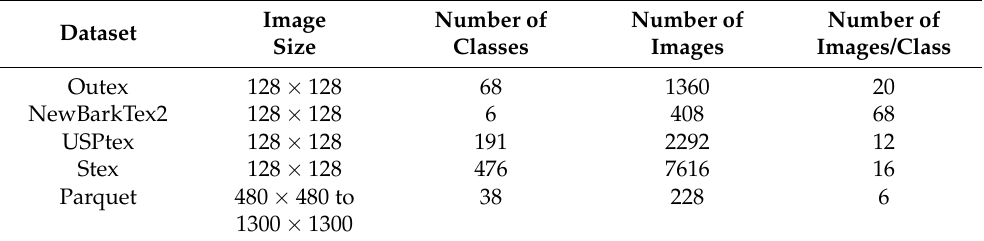
Figure 9. Samples of the OAK wood category from the Parquet dataset among the 38 color tex- ture classes. Table 2 summarizes the color texture datasets used in the experiments of this paper. Table 2. Experimented color texture